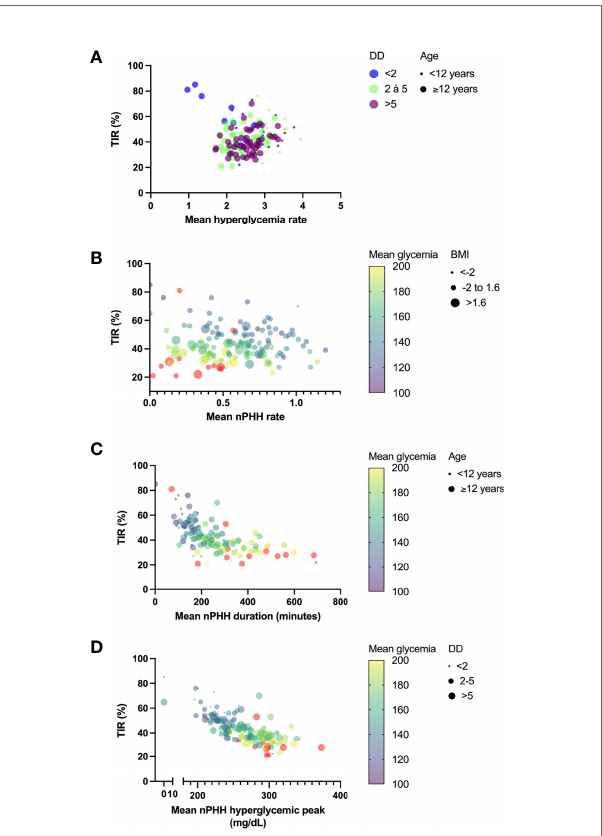
FIGURE 4 | Principal determinants of PHH main characteristics. Graphs represent principal determinants of hyperglycemia rate (A) , PHH rate (B) , PHH duration (C) and PHH hyperglycemic peak (D) . (A) Relations between TIR and hyperglycemia rate were decomposed into diabetes durations (dots with color code) and age (dot size). Although TIR did not correlate with hyperglycemia rate in multiple linear regression analysis (p=0.24), it was represented in y axis for homogenization across the graphs. (B) Relations between TIR and PHH rate were decomposed into mean glycemia (dots with continuous colored purple-yellow gradient) and BMI (dot size). (C) Relations between TIR and PHH duration were decomposed into mean glycemia (dots with continuous colored purple-yellow gradient) and age (dot size). (D) Relations between TIR and hyperglycemic peak were decomposed into mean glycemia (dots with continuous colored purple-yellow gradient) and diabetes duration (dot size), although this later parameter did not signi fi cantly correlate with mean hyperglycemic peak (p=0.09). TIR, time in range; DD, diabetes duration; PHH, post-hypoglycemic hyperglycemia; BMI, body mass index.